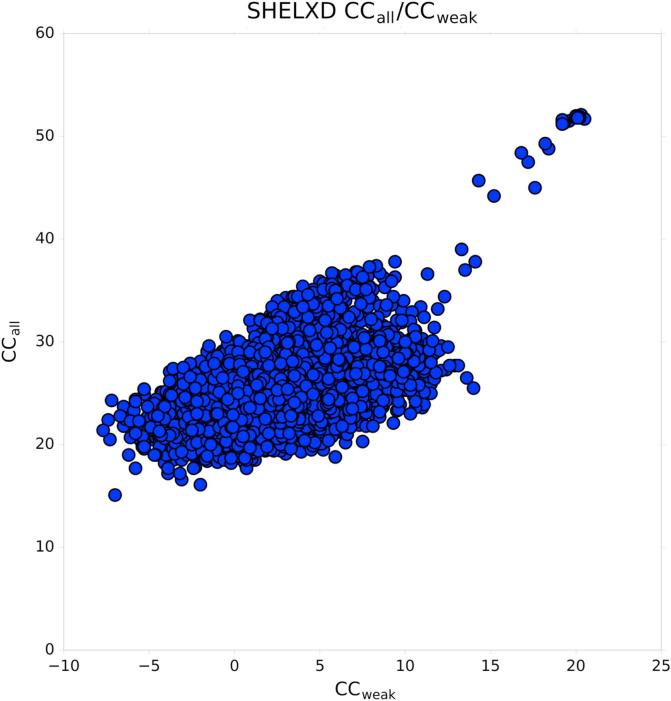
10,000 substructure solution attempts, searching for 9 sites, with SHELXD plotted with CCweak vs CCall for the λ = 4.96 Å dataset.